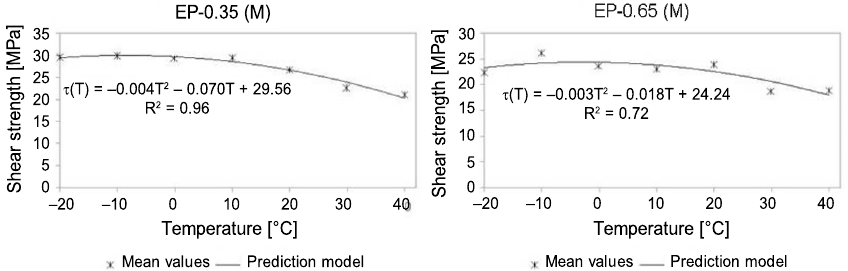
Fig. 6. Shear strength vs. temperature for EP-0.35(M) and